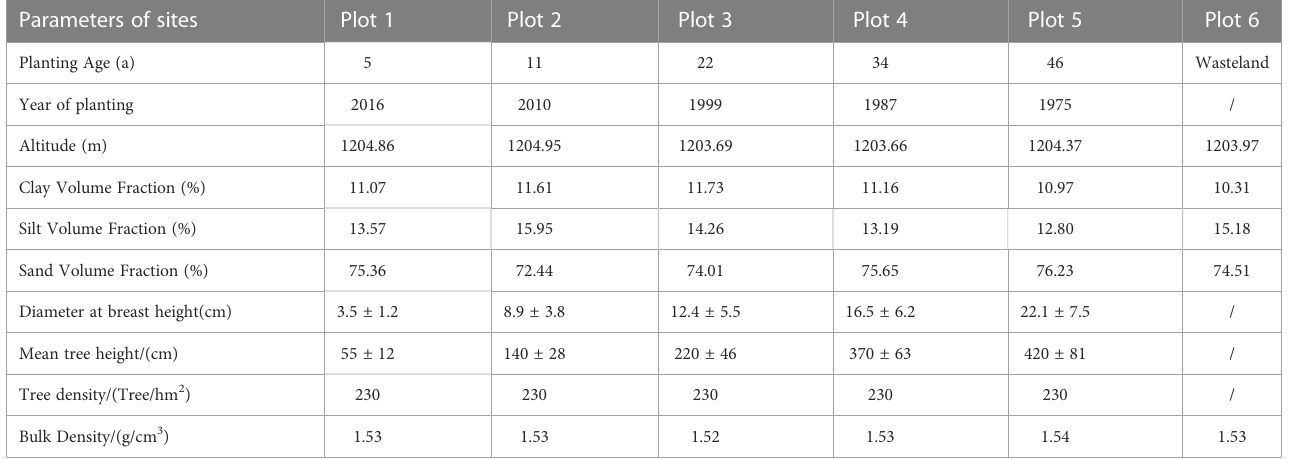
TABLE 1 Characteristics of Haloxylon ammodendron (HA) plantation lands at different plots. Parameters of sites Plot 1 Plot 2 Plot 3 Plot 4 Plot